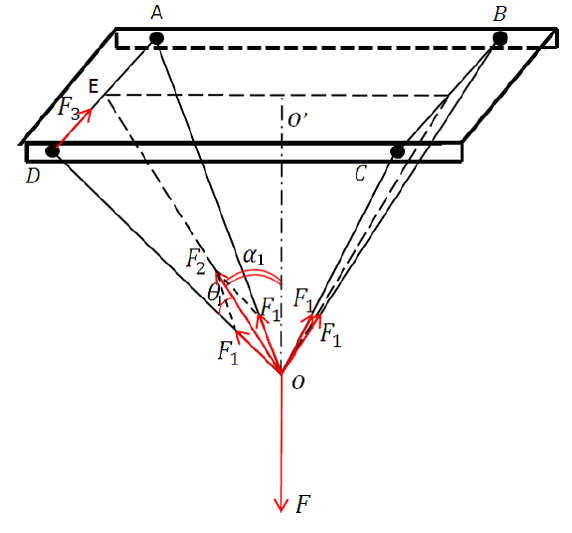
Figure 15. The scheme of tensile force measurement for the attitude